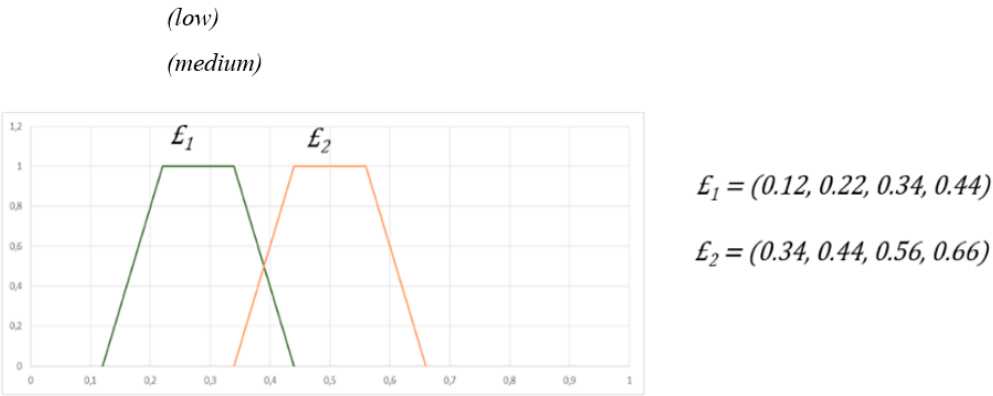
Figure 7. Fuzzy trapezoidal number illustration.